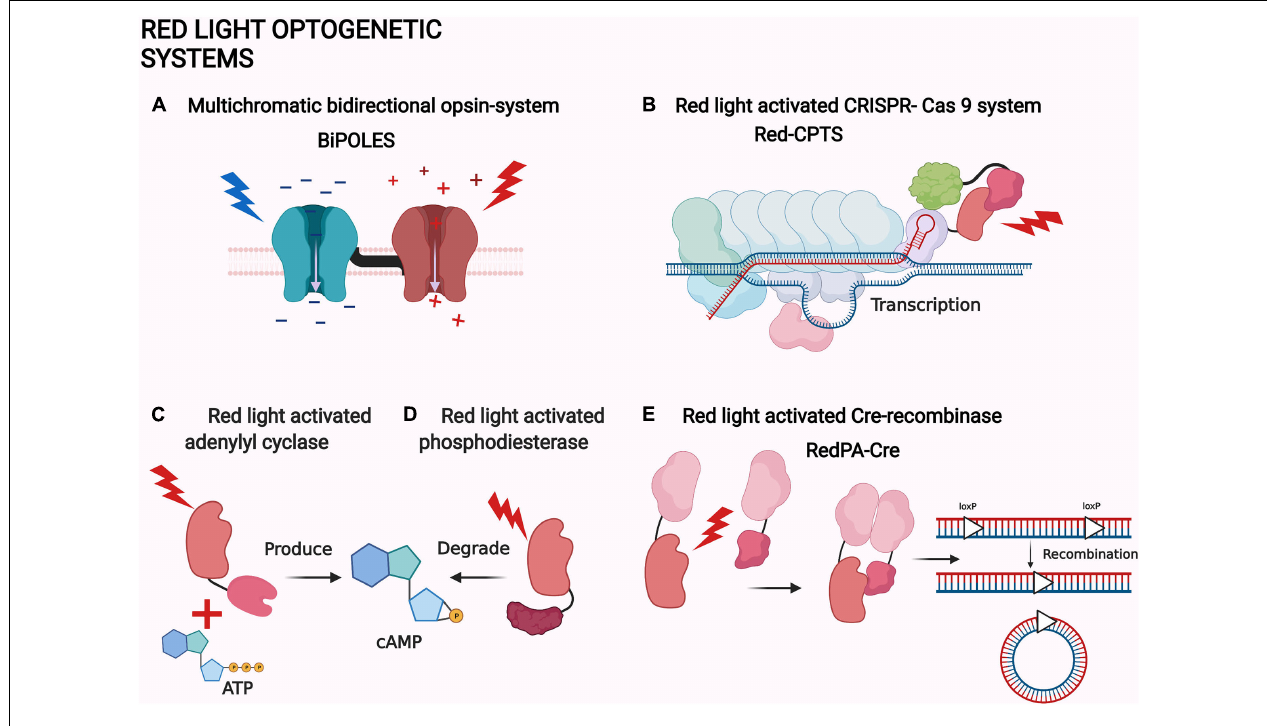
FIGURE 4 | Examples of red light optogenetic systems. (A) Multichromatic directional opsin system BiPOLES (Vierock et al., 2021). (B) Red light-activated CRISPR-Cas 9 system Red-CPTS (Kuwasaki et al., 2021). (C) Red light-activated adenylyl cyclase (Fomicheva et al., 2019). (D) Red light-activated phosphodiesterase (Stabel et al., 2019). (E) Red light-activated Cre-recombinase RedPA-Cre (Kuwasaki et al., 2021). The same protein components are depicted with a similar shape in each panel. The shapes are not accurate depictions of the proteins and are not to scale. The illumination of each actuator is depicted as lightning and colored according to each system. The figure was created with